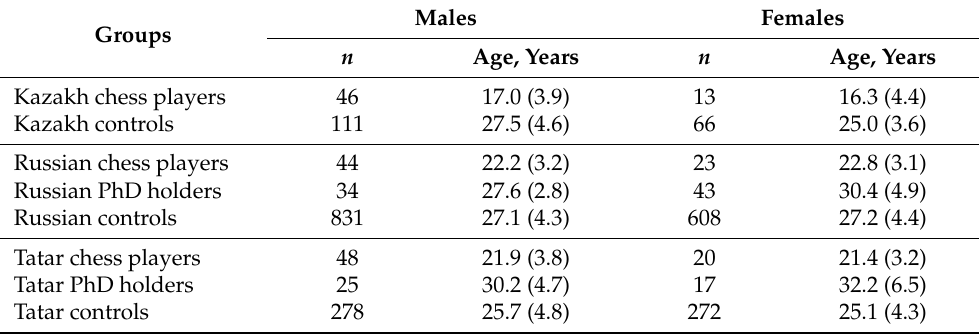
Table 1. Characteristics of studied